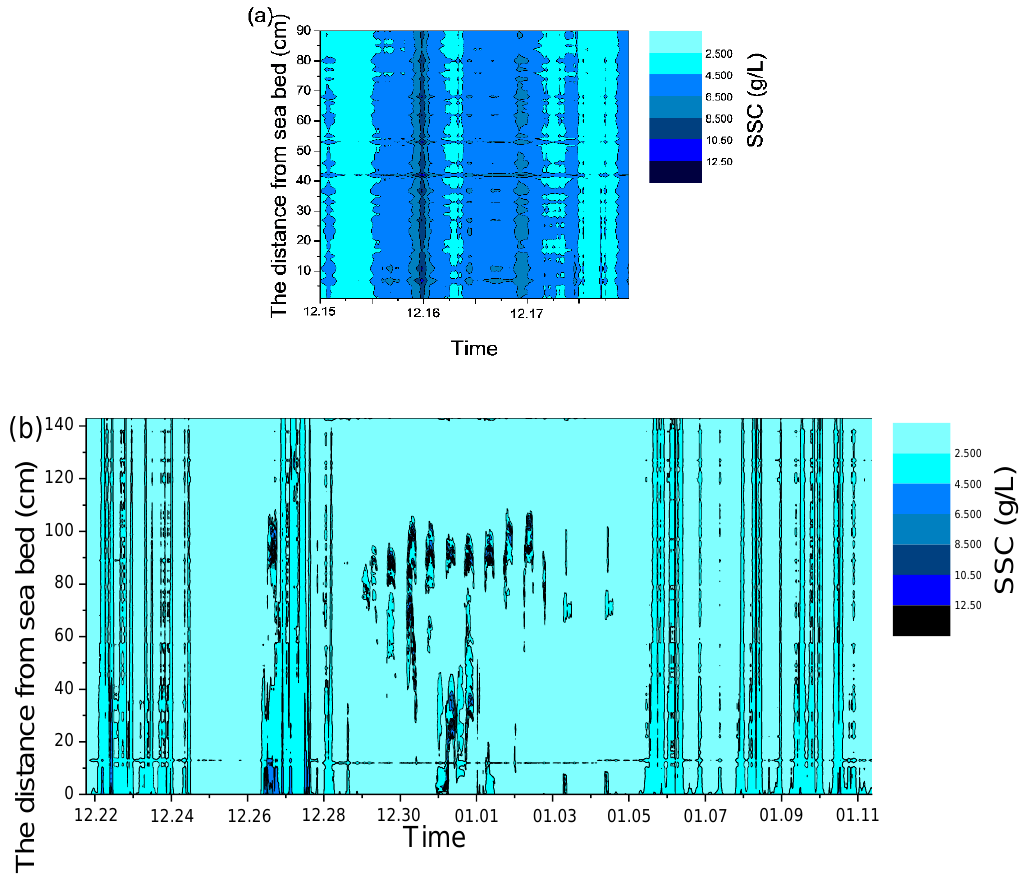
Figure 6. SSC, which was mainly less than 2.5 g/L, and its profiles during the periods of ( a ) 15 – 17